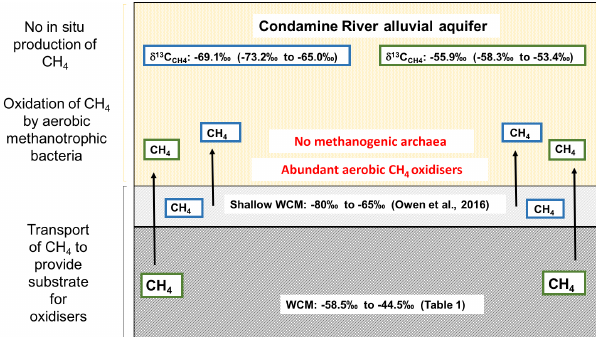
Figure 6. A conceptual schematic of the processes occurring be- tween the WCM and the